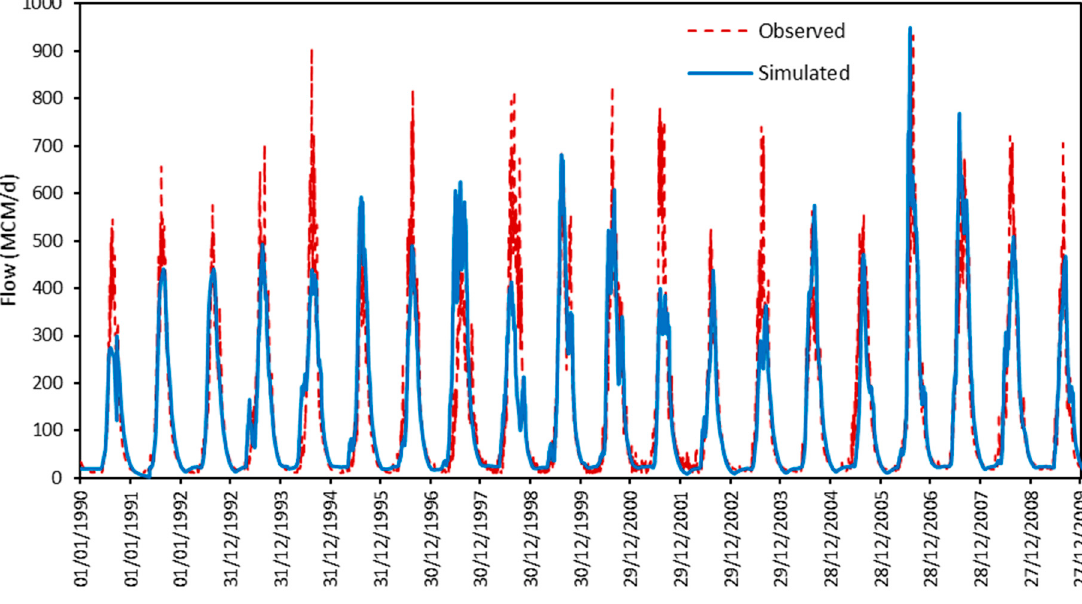
Figure 7. The comparison of observed and simulated flow at Diem station for the calibrated period. The differences may be attributed to the lack of detailed areal estimation of rainfall.